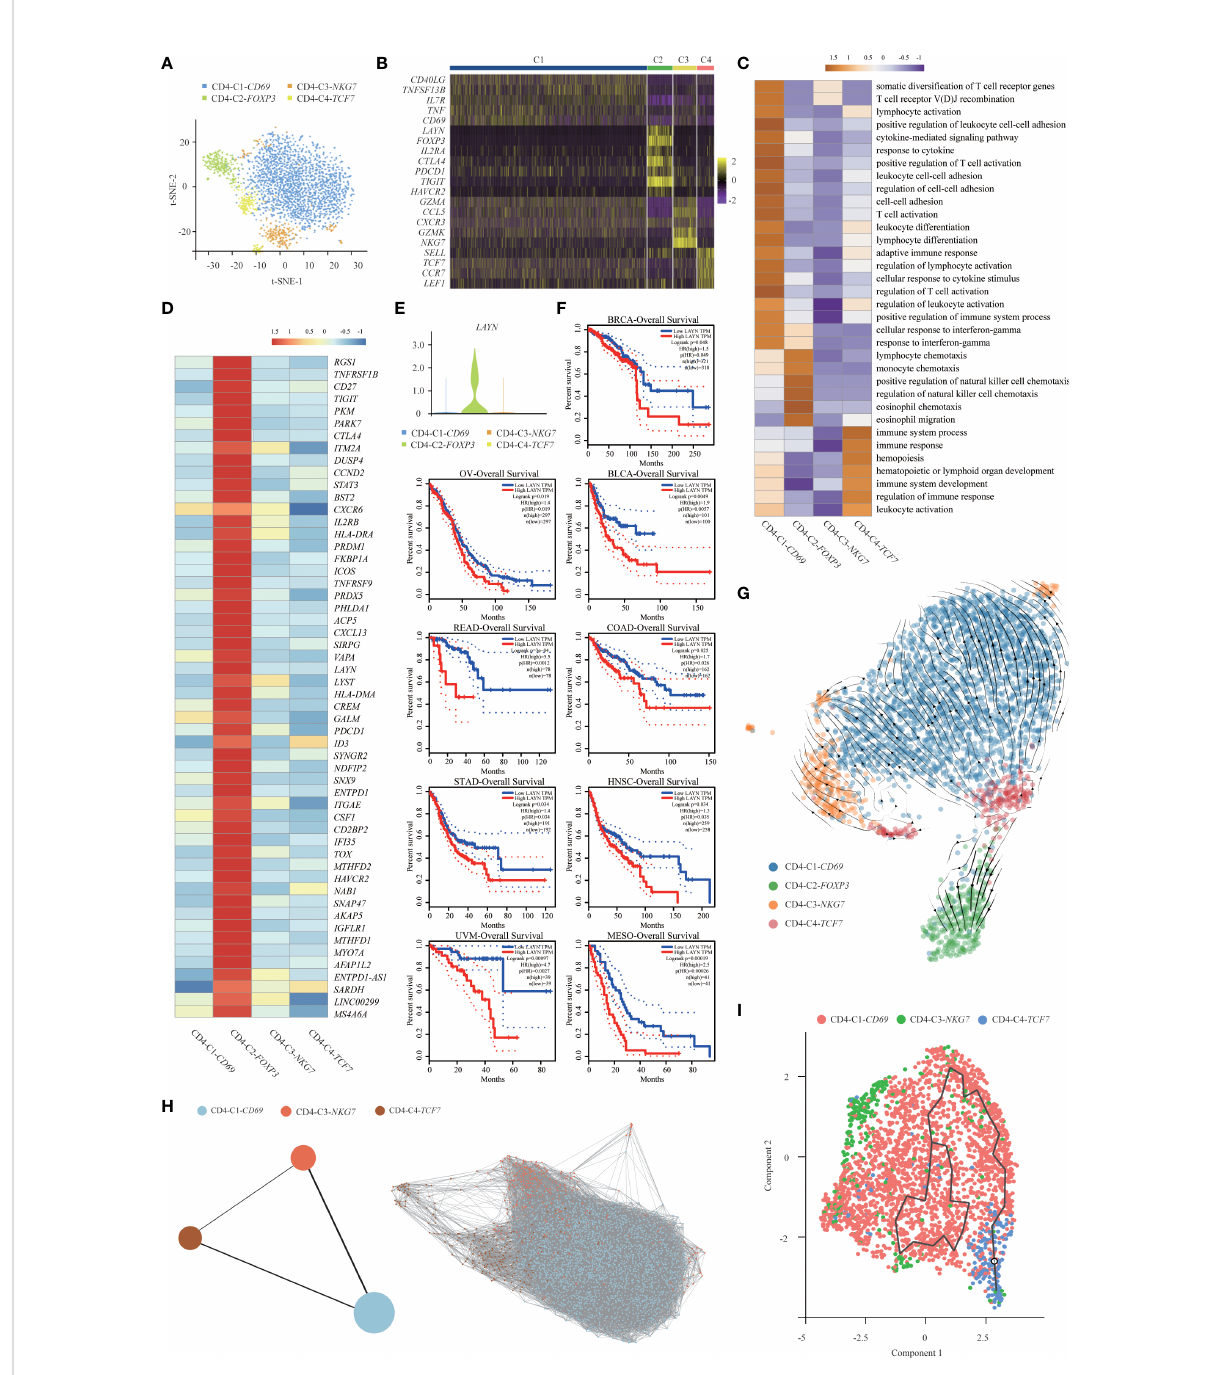
FIGURE 3 Gene expression heterogeneity of CD4 + T cell subsets was identi fi ed in the SUPS. (A) t-SNE plot showing the four main subsets of CD4 + T cells. (B) Heatmap showing speci fi c marker genes in each CD4 + T cells cluster (each column represents an individual cluster; purple represents the minimum, black represents the median, and yellow represents the maximum expression values). (C) Functional enrichment analysis of upregulated genes in each CD4 + T cells cluster was performed with GO analysis. (D) Heatmap comparing the expression of exhaustion-related genes in CD4 + T cells cluster. (E) Violin plot comparing the expression of LAYN in CD4 + T cells cluster. (F) The disease-free survival curve based on TCGA data showed patients with higher expression of LAYN had poor prognoses. (G) RNA velocities are visualized on the UMAP projection of CD4 + T cell populations, colored by clusters. (H) Pseudotime trajectories for CD4 + T cells (CD4-C1- CD69 , CD4-C3- NKG7 , CD4-C4- TCF7 ) based on PAGA. (I) The Monocle 3 trajectory plot shows the dynamics of CD4-C1- CD69 , CD4-C3- NKG7 and CD4-C4- TCF7